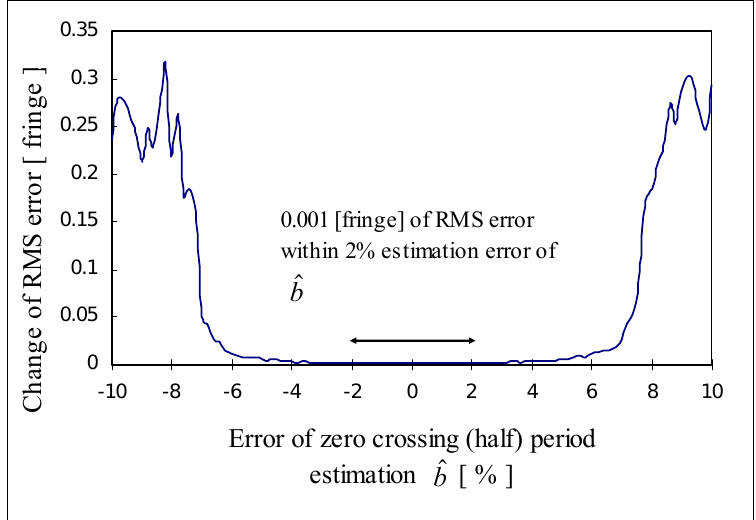
Figure 14 . Change of RME error as a function of estimation error in zero crossing